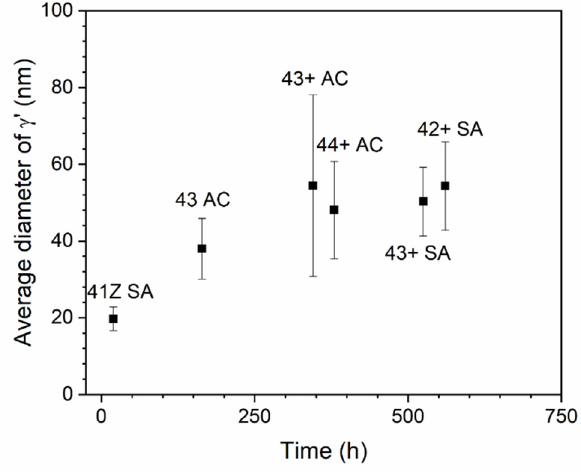
Figure 12. Average diameter of γ ’-Ni 3 (Al,Ti) precipitates measured for the creep tested alloys at 750 °C.